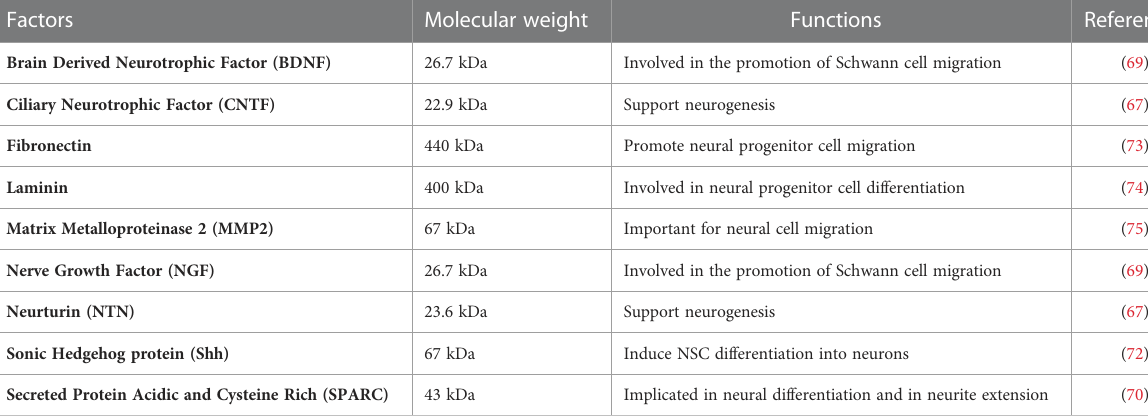
TABLE 1 OEC released factors involved in neural differentiation and